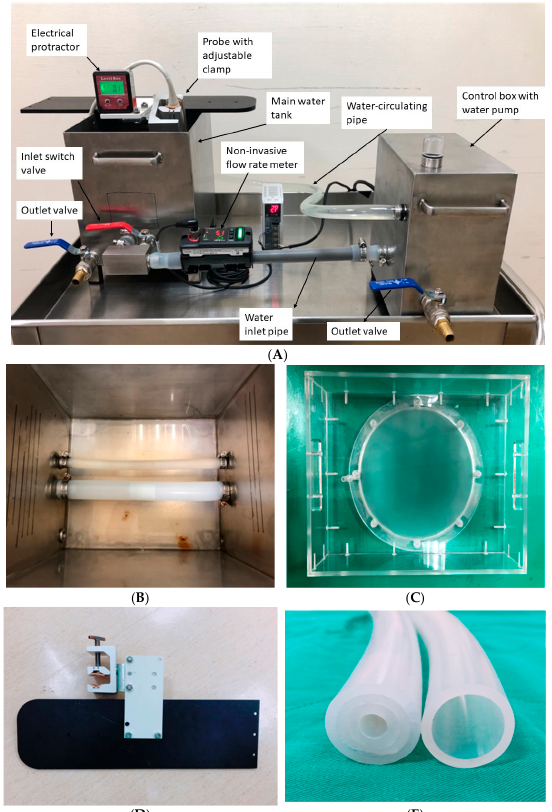
Figure 1. ( A ). The left part is the main water tank. The right part is the control box, whereas the central electronic device is a noninvasive flow rate meter. ( B ) The inner part of the water tank (L × W × H; 244 × 194 × 202 mm 3 ). It includes two silicon pipes with inner diameters of 19 and 10 mm, respectively; ( C ) 2-mm-thick silicon film 175 mm in diameter, simulating human skin, which could be pressed tightly over the water surface; ( D ) a close-up view of the adjustable clamp, which pro- vides the required probe for scanning; and ( E ) the artificial stenosis made by a silicon pipe similar to the pipe adopted in this work.